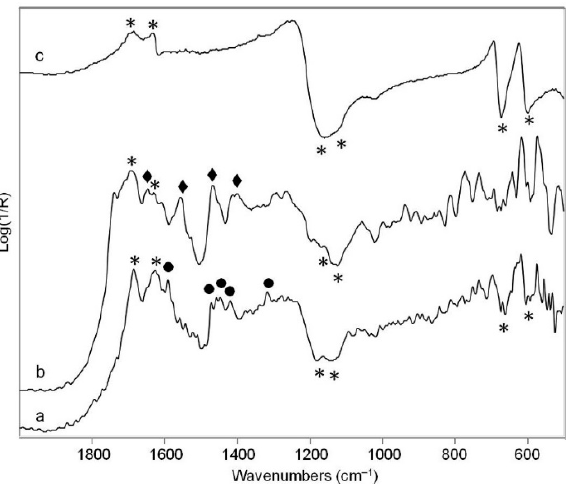
Figure 4. FTIR spectra acquired “in situ” in reflection mode on: ( a ) area with green patina F13-1; ( b ) yellow-reddish area F13-3; ( c ) unaltered area F3-1. Legend: (*) bands due to gypsum; ( ) bands due to copper carboxylates; ( ) bands due to a proteinaceous component (possibly gelatin).